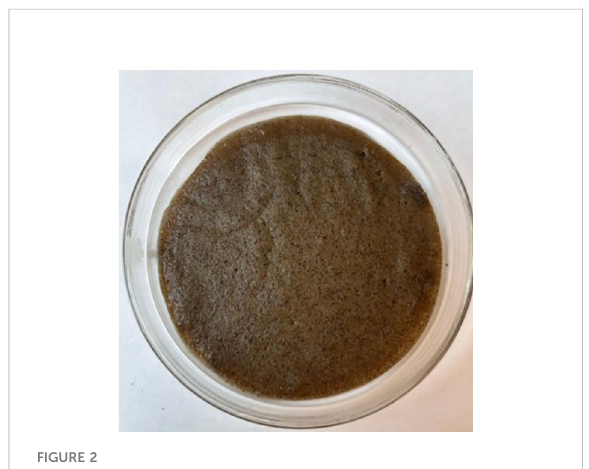
FIGURE 2 Bioplastic fi lm derived from the algal – plant